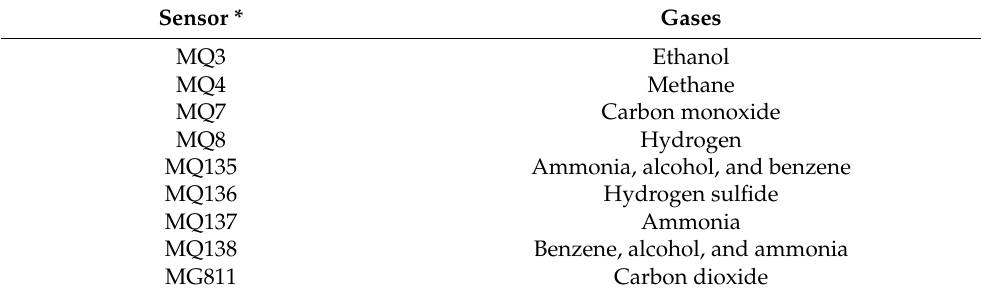
Table 1. Sensors integrated in the electronic nose and the gases to which they are sensitive. Sensor * Gases MQ3 Ethanol MQ4 Methane MQ7 Carbon monoxide MQ8